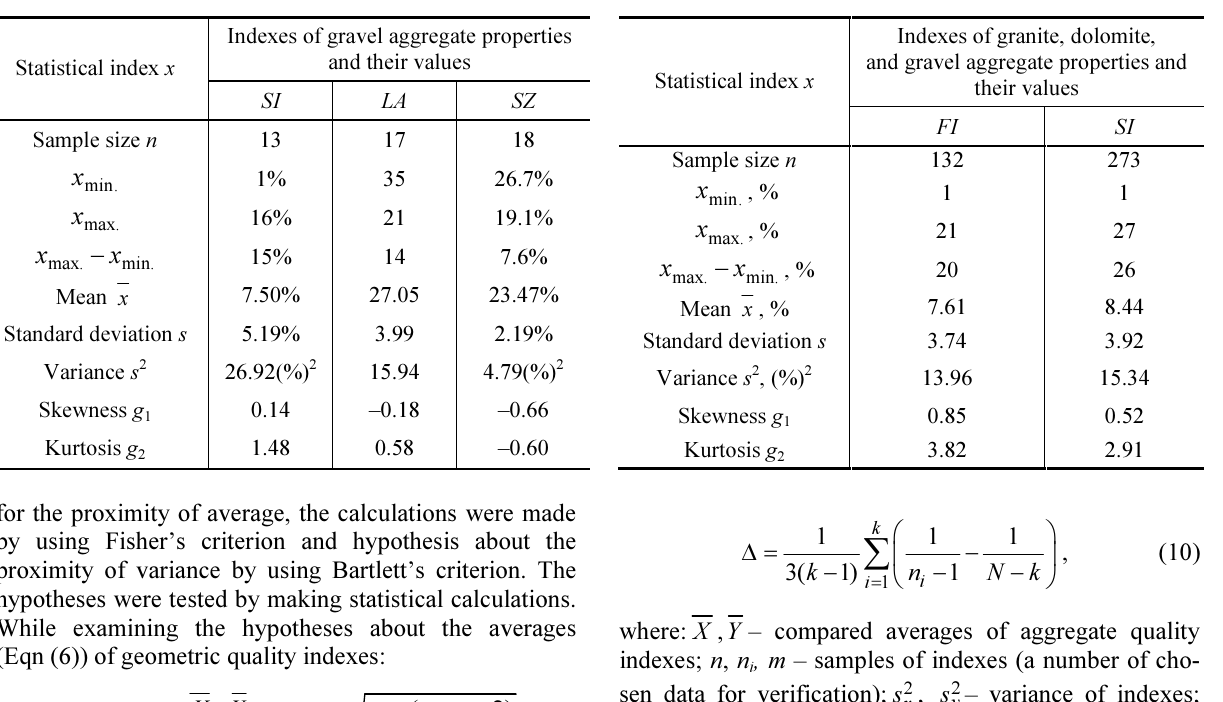
Table 3. Summary of mechanical indexes SI , LA , and SZ of gravel aggregate